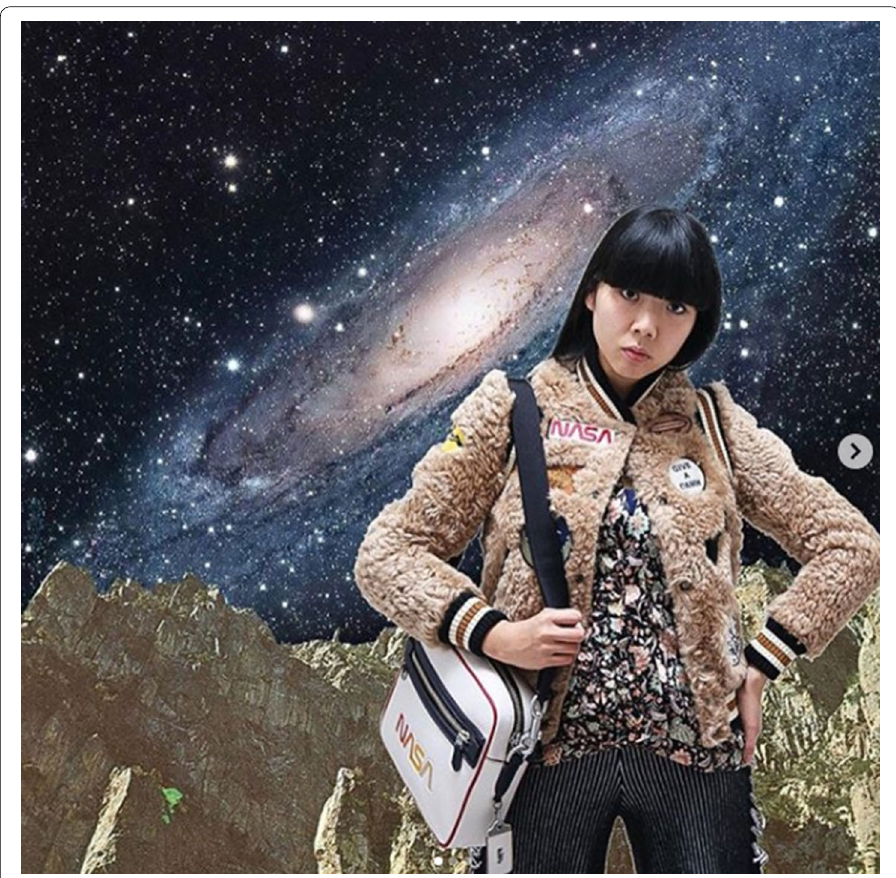
Fig. 13 Reliving the space race. https ://www.insta gram.com/p/BUxFt PyFuO v/. Accessed 22 September